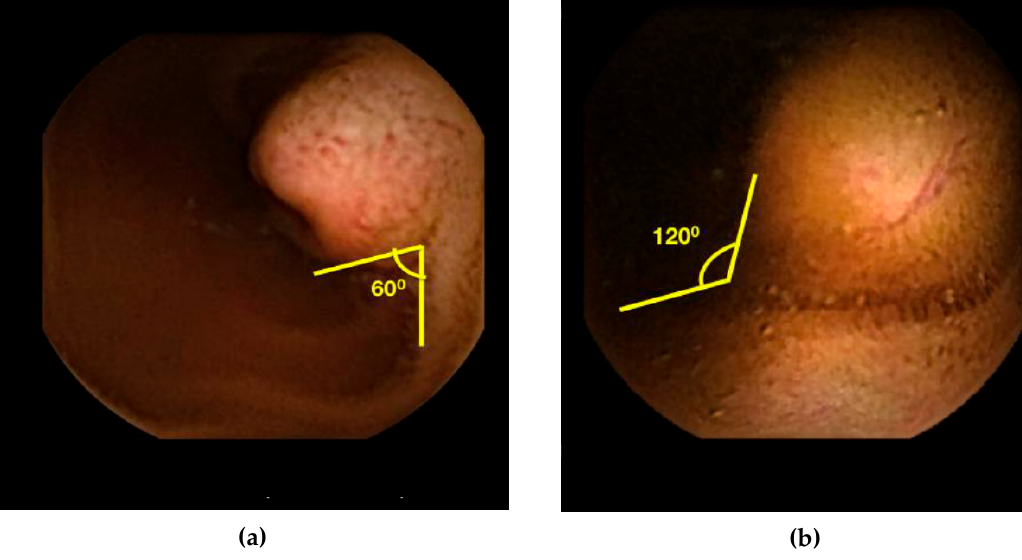
Figure 1. ( a ) Demonstration of acute angle measurement on RAPID TM . ( b ) Demonstration of obtuse angle measurement on RAPID TM .